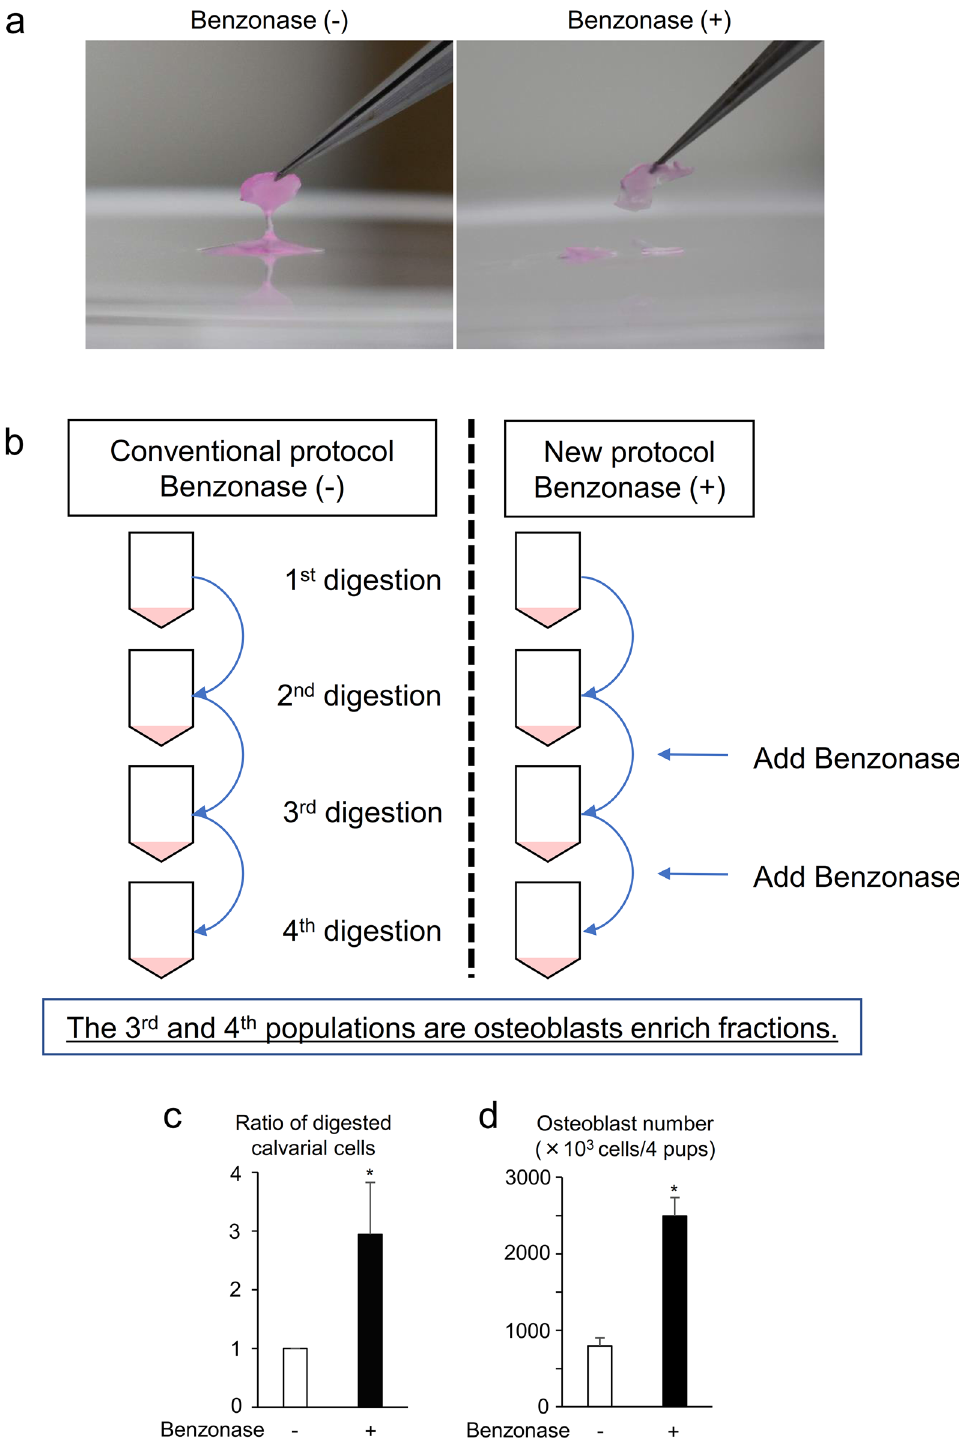
Figure 1. Benzonase increased the number of collected osteoblasts from calvariae. ( a ) Representative images of digested calvariae with digestion solution in the presence (right) or absence (left) of Benzonase. ( b ) Schematic process of calvarial digestion with digestion solution in the presence (right) or absence (left) of Benzonase. ( c ) The ratio of digested calvarial cells in the 3rd and 4th populations from newborn pups in the presence or absence of Benzonase. n = 5. ( d ) Total number of expanded and collected osteoblasts from calvariae from 4 newborn pups with digestion solution in the presence or absence of Benzonase. n = 3. P values were determined by the unpaired t-test. Data are presented as means ± SEM. * P <